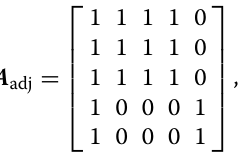
Fig. 3 State machine for reconstructible 4-ASK sequences, with dependency on the whole prior sequence, P